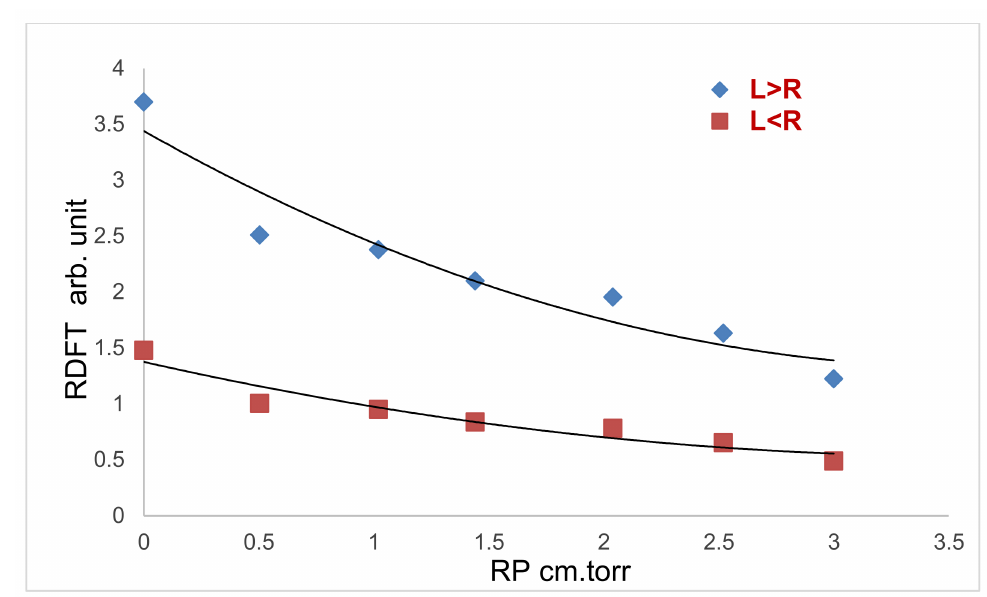
Figure 2. Theoretical and experimental comparison between the radial distribution of the electron temperature (RDFT) from the center (R P = 0) to the edge for R > L > R, at P = 1.2